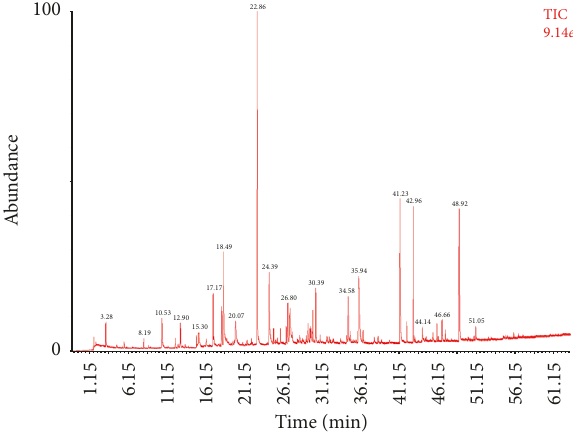
Figure 3: A typical GC-MS Chromatogram obtained from